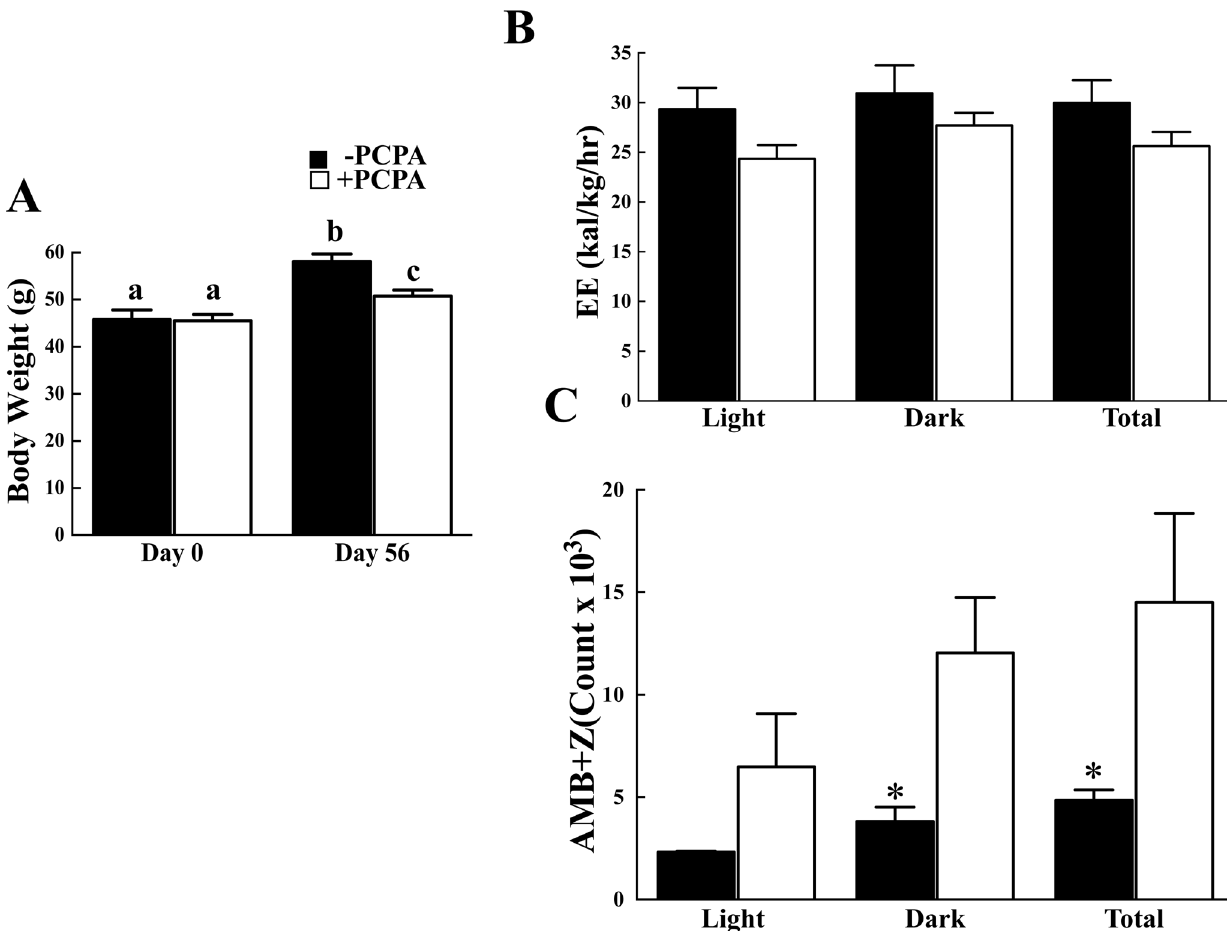
Figure 6. 2-PCPA treatment reduces adiposity in ob/ob mice associated with increased locomotor activity. Pair-fed ob/ob mice were maintained on a normal chow diet for 7 weeks and then injected PCPA intraperitoneally every other day for a total of three times during the last week. (A) Body weights were initially measured and then two days after the third injection. Indirect Calorimetry was carried out immediately after the third injection. (B) Average energy expenditure during the 12-hour light cycle from 7 am to 7 pm and the 12-hour dark cycle from 7 pm to 7 am. (C) The sum of ambulatory and vertical movements. Panels (B) and (C) error bars represent means 6 standard errors of each group (n=5). (*) indicates a statistically significant difference (p , 0.05) between the 2-PCPA treated and non-treated groups. In panel (A), statistical analysis was performed using a two-way ANOVA followed by the Student-Newman-Keuls multiple range test. Identical letters indicate data points that are not statistically different from each other (p ,